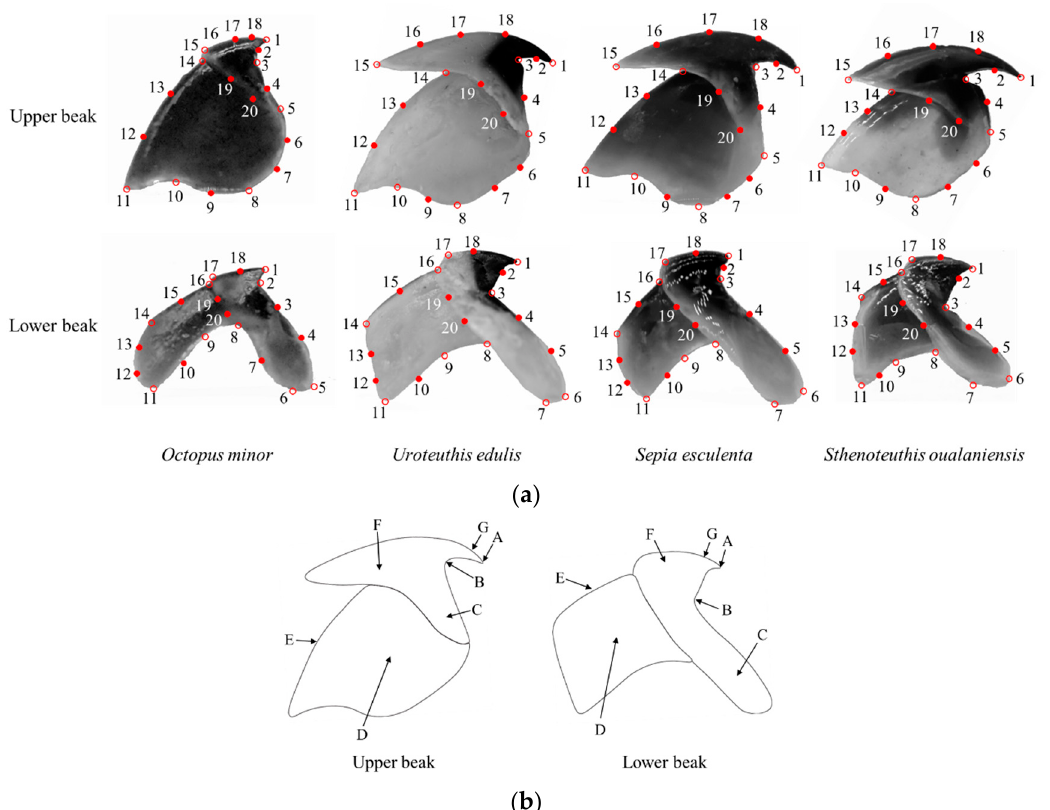
Figure 1. Shape and digitized landmarks (hollow dots) and semi-landmarks (solid dots) of the Cephalopods beak. ( a ): Landmark positions. ( b ): Shape description—A: Rostral tip, B: Jaw angle, C: Wing, D: Lateral wall, E: Crest, F: Hood, G: Rostrum.